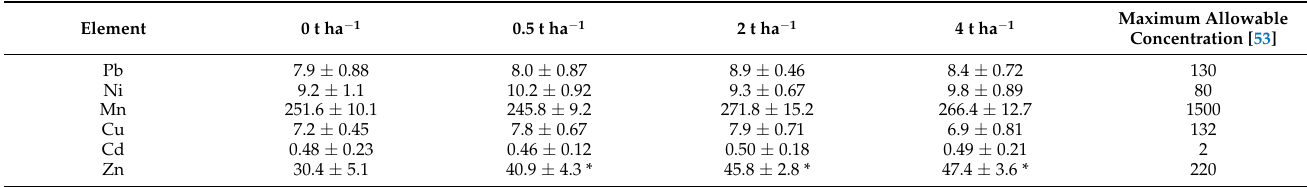
Table 2. Heavy metal concentration in soils, mg kg − 1 .